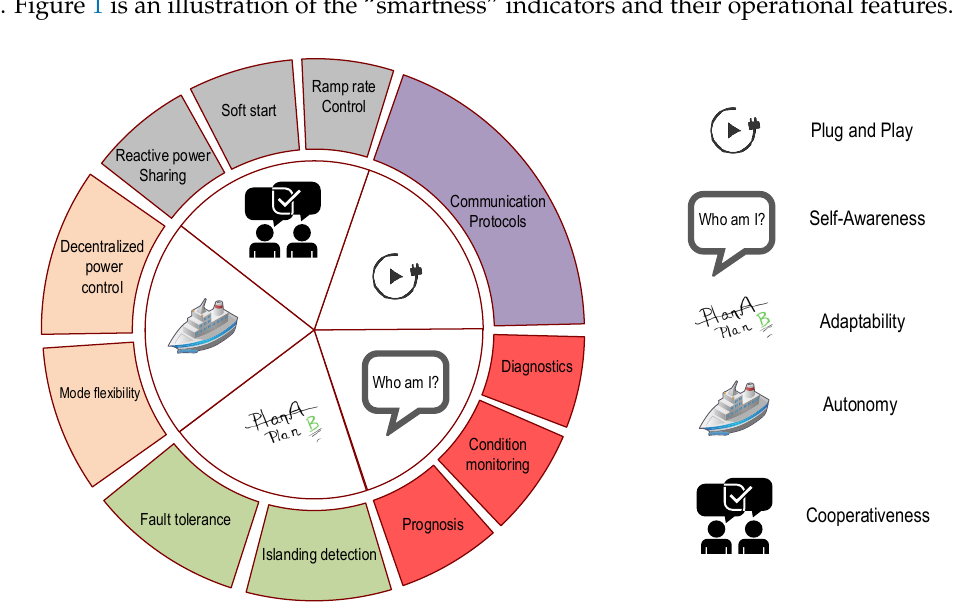
Figure 1. Indicators of smartness for smart inverters.